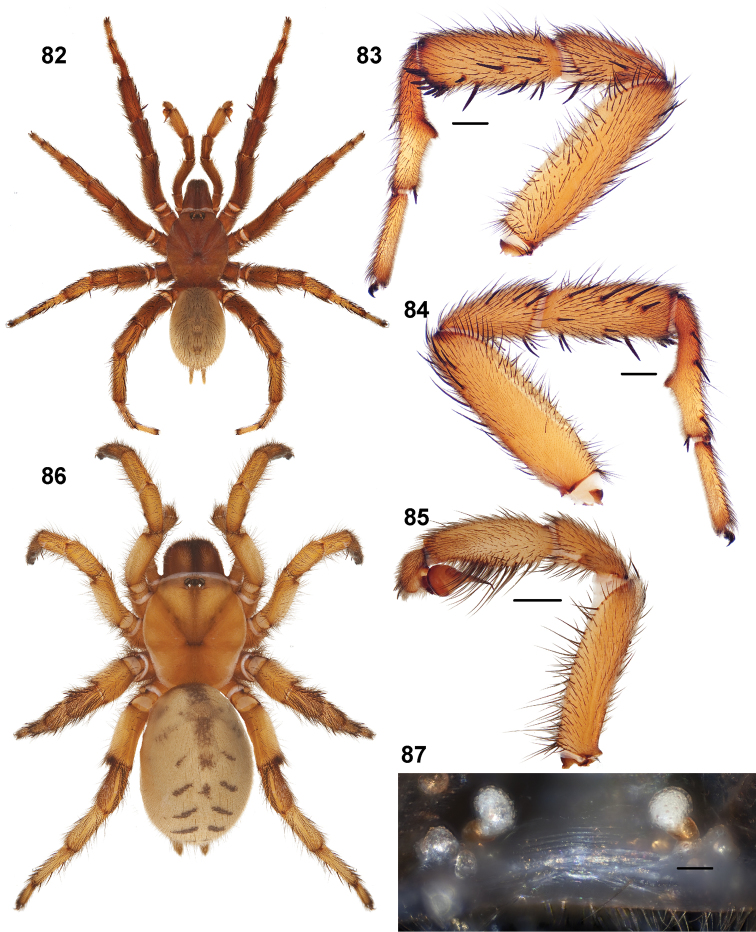
Aptostichus stephencolberti Bond, 2008. 82 male habitus from San Francisco Co. (AP156) [805762] 83–85 male holotype from San Mateo Co., Pescadero State Beach (MY3515); scale bar = 1.0mm 83 retrolateral aspect leg I [805751] 84 prolateral aspect leg I [805747] 85 retrolateral aspect pedipalp [805753] 86 female habitus from Santa Cruz Co., Waddell Creek Beach (MY3508) [805758] 87 cleared spermathecae, from San Luis Obispo Co., Wilder Ranch State Beach (MY3500) [805754]; scale bar = 0.25mm.